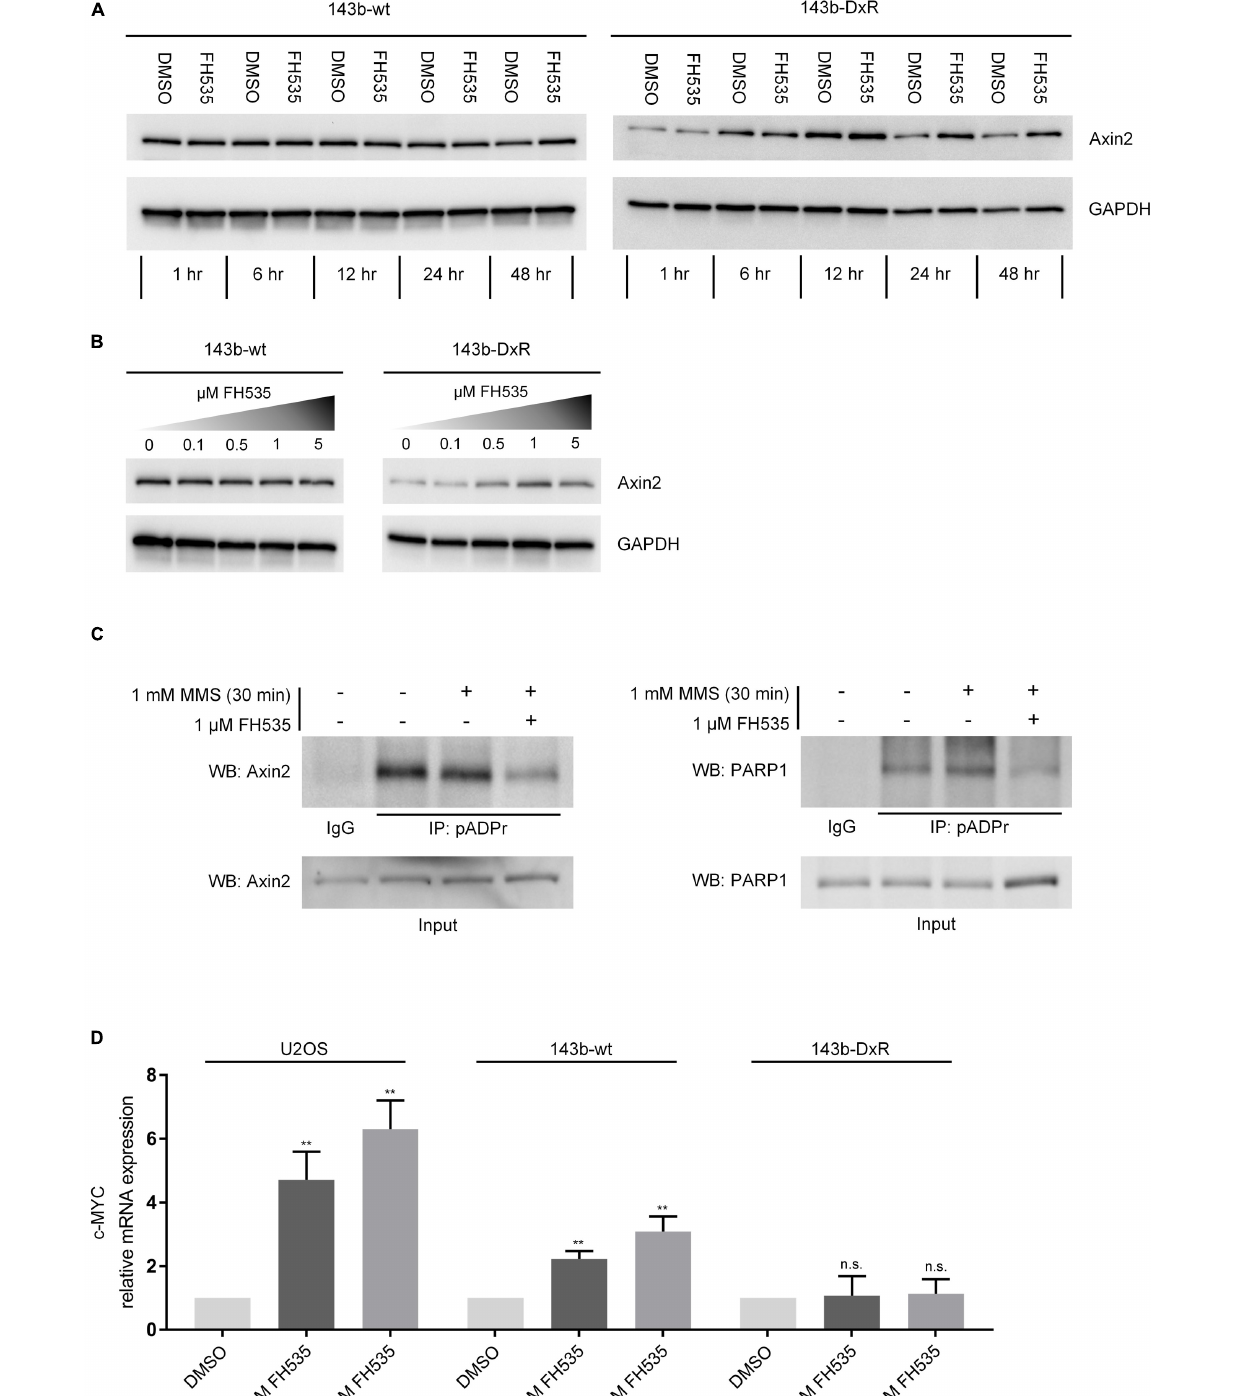
Frontiers in Pharmacology |